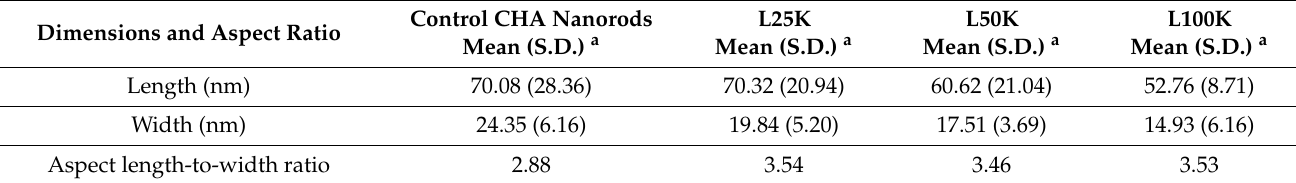
Figure 1. ( a ) XRD pattern of carbonated apatite nanorods templated with pharmaceutical heparin and prepared by hydrothermal synthesis. ( b ) The infrared absorption spectrum of carbonated apatite nanorods templated with pharma- ceutical heparin and prepared by hydrothermal synthesis. ( c ) TEM image of carbonated apatite nanorods templated with pharmaceutical heparin and prepared by hydrothermal synthesis. Table 2. Average length, width, and the length-to-width ratio of carbonated apatite nanorods templated with different concentrations of pharmaceutical heparin ( n =